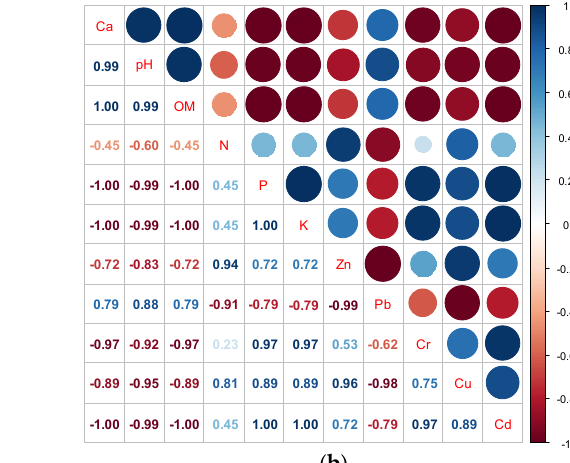
Figure 2. Principal components analysis (PCA) ( a ) and heatmap of Pearson moment correlation coefficients ( b ) for the soil’s chemical properties (CaCO 3 —Ca, pH, organic matter—OM, total N—N, P 2 O 5 —P, K 2 O—K, Zn, Pb, Cr, Cu, and Cd) at analyzed localities. The analyzed factors (locality, genotype, and phenophase) and their interactions significantly influenced the variability of the heavy metal content in wheat roots (Figure 3 and Table 2). The results indicate that the highest concentrations of Zn (8.69 mg kg − 1 ) and Cu (4.54 mg kg − 1 ) in the plant’s roots were found at location L1, which is the closest to the industrial zone, while the highest concentration of Pb (2.32 mg kg − 1 ) and Cr (2.67 mg kg − 1 ) was found in the samples collected at location L3, which is the farthest from the industrial zone (Figure 3a). The amount of variance explained by the genotype impact was significant for each element (Table S1) since the studied genotypes varied from one another in the amounts of heavy metals (Figure 3c). The greatest effect of genotype was found in the total variation of Cu (29.23%), followed by Pb (22.58%), while the smallest share of this factor was found in the variation of Cr (8.41%) (Table S1). The highest concentrations of Cr (2.51 mg kg − 1 ), Cu (4.78 mg kg − 1 ), and Cd (together with the genotype Apache) were found in the roots of the genotype Renesansa (0.12 mg kg − 1 ). On the other hand, the genotype Pobeda exhibited the greatest amounts of Zn (7.90 mg kg − 1 ) and Pb, along with the genotype